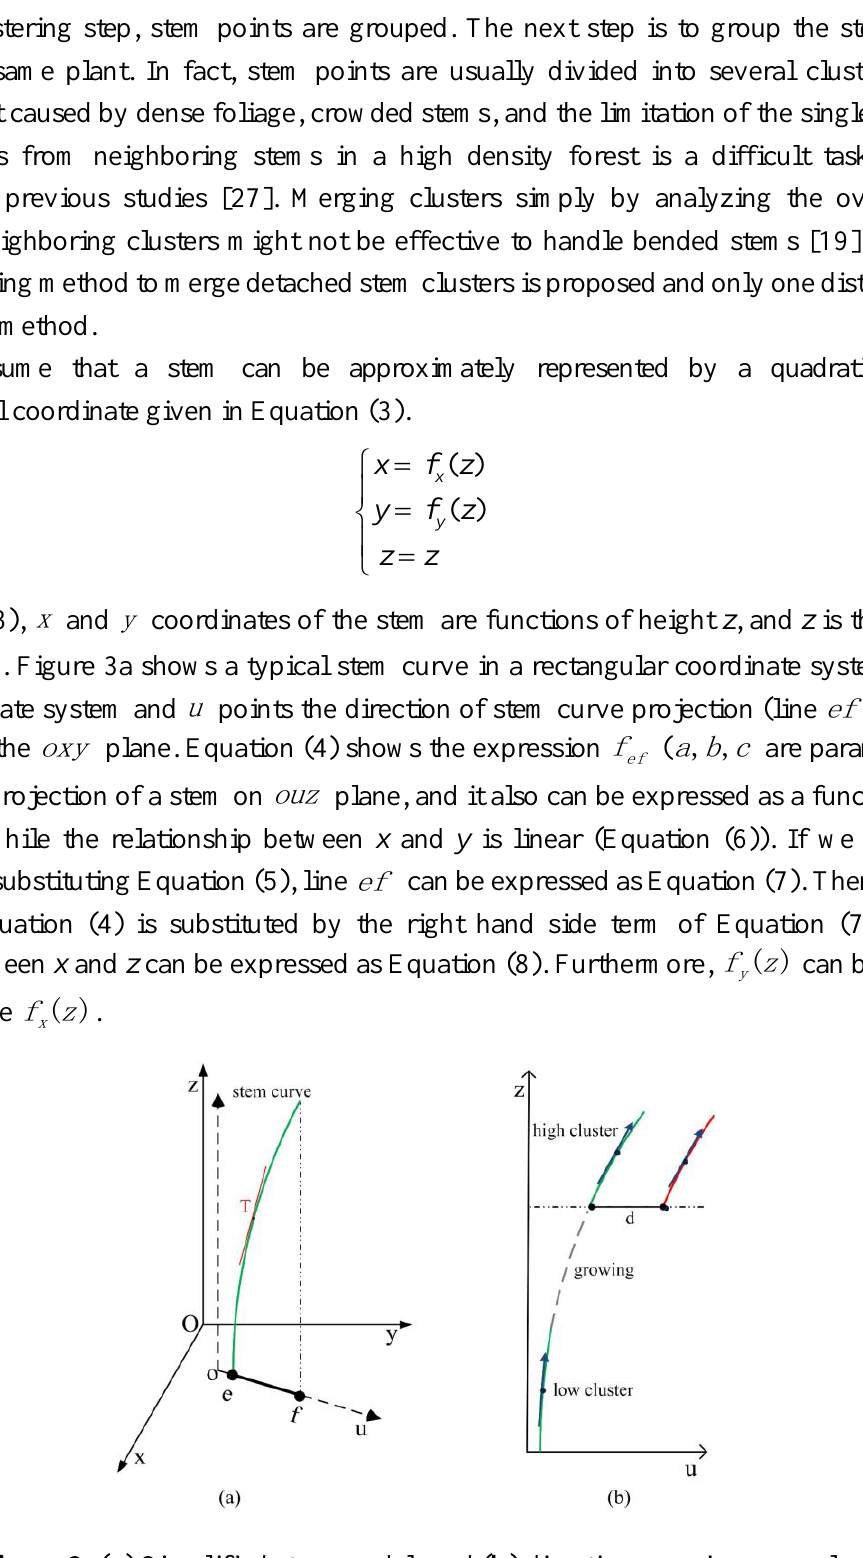
Figure 3. ( a ) Simplified stem model; and ( b ) direction-growing